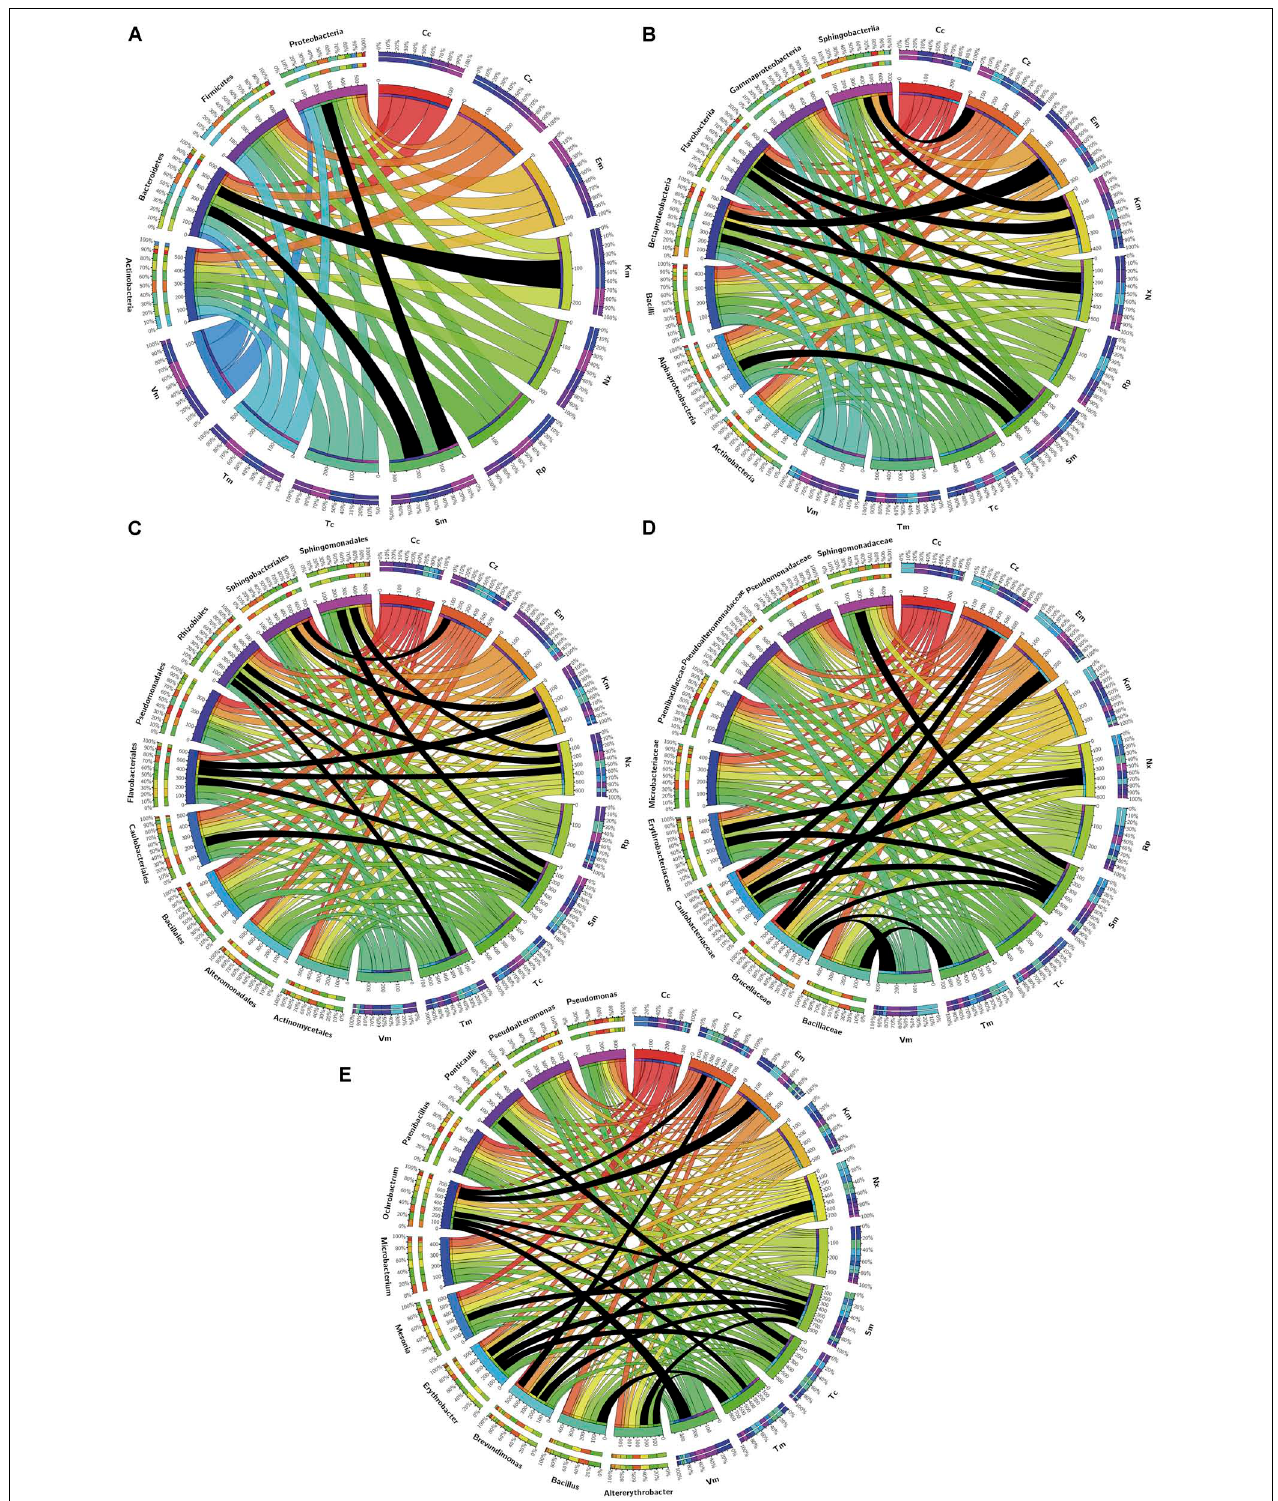
FIGURE 5 | Distribution among phylogenetic groups of isolates resistant to the tested antibiotics. Graphs correspond to (A) phylum, (B) class, (C) order, (D) family, and (E) genus. Ribbons connect the antibiotic to which resistance was detected with the phylogenetic group to which resistant isolates were assigned. The wideness of each ribbon represents the percentage of isolates within each phylogenetic group resistant to the antibiotic that it connects to. Black ribbons correspond to percentages of isolates ≥ 90%.